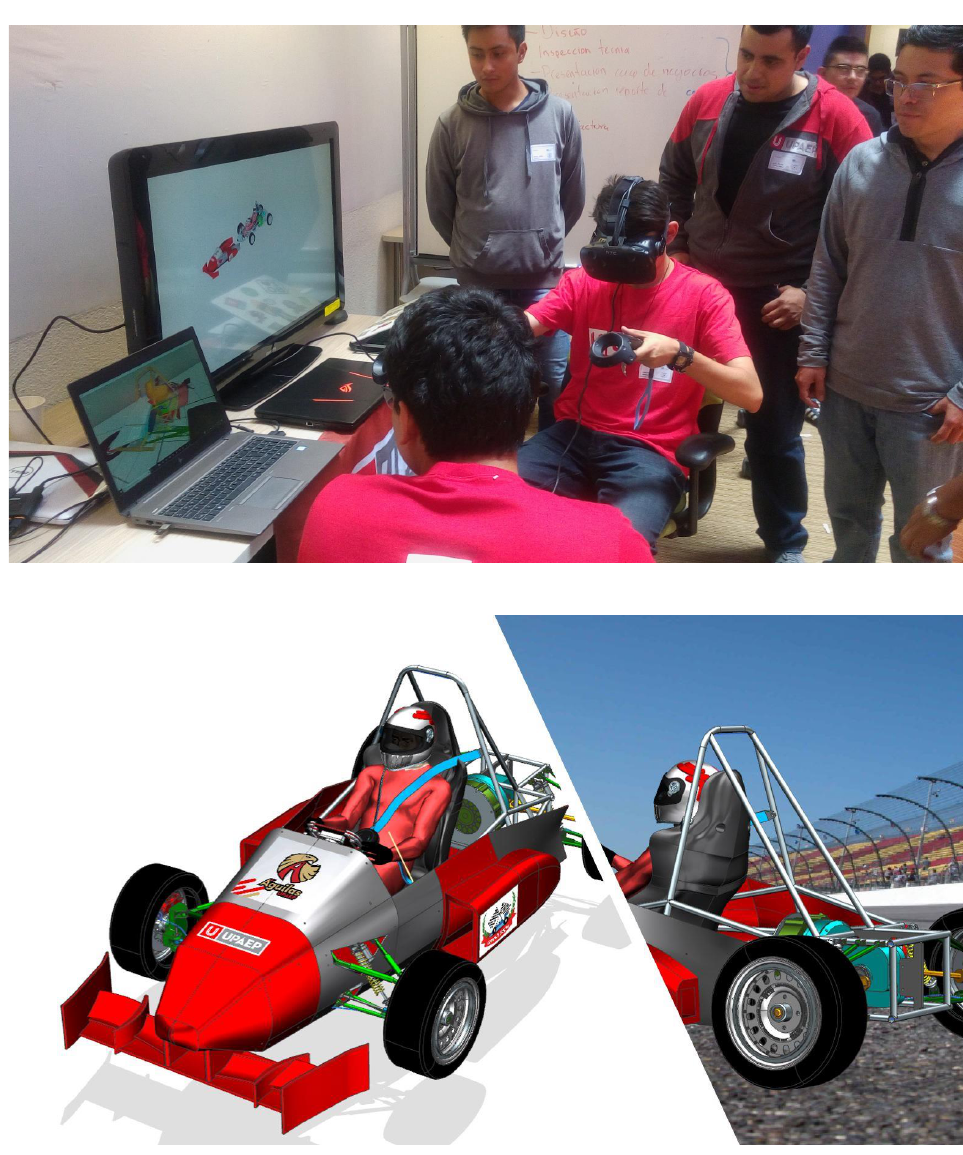
Figure 5. Digital and virtual validation of the Formula SAE-UPAEP project at the VR/AR laboratory at UPAEP